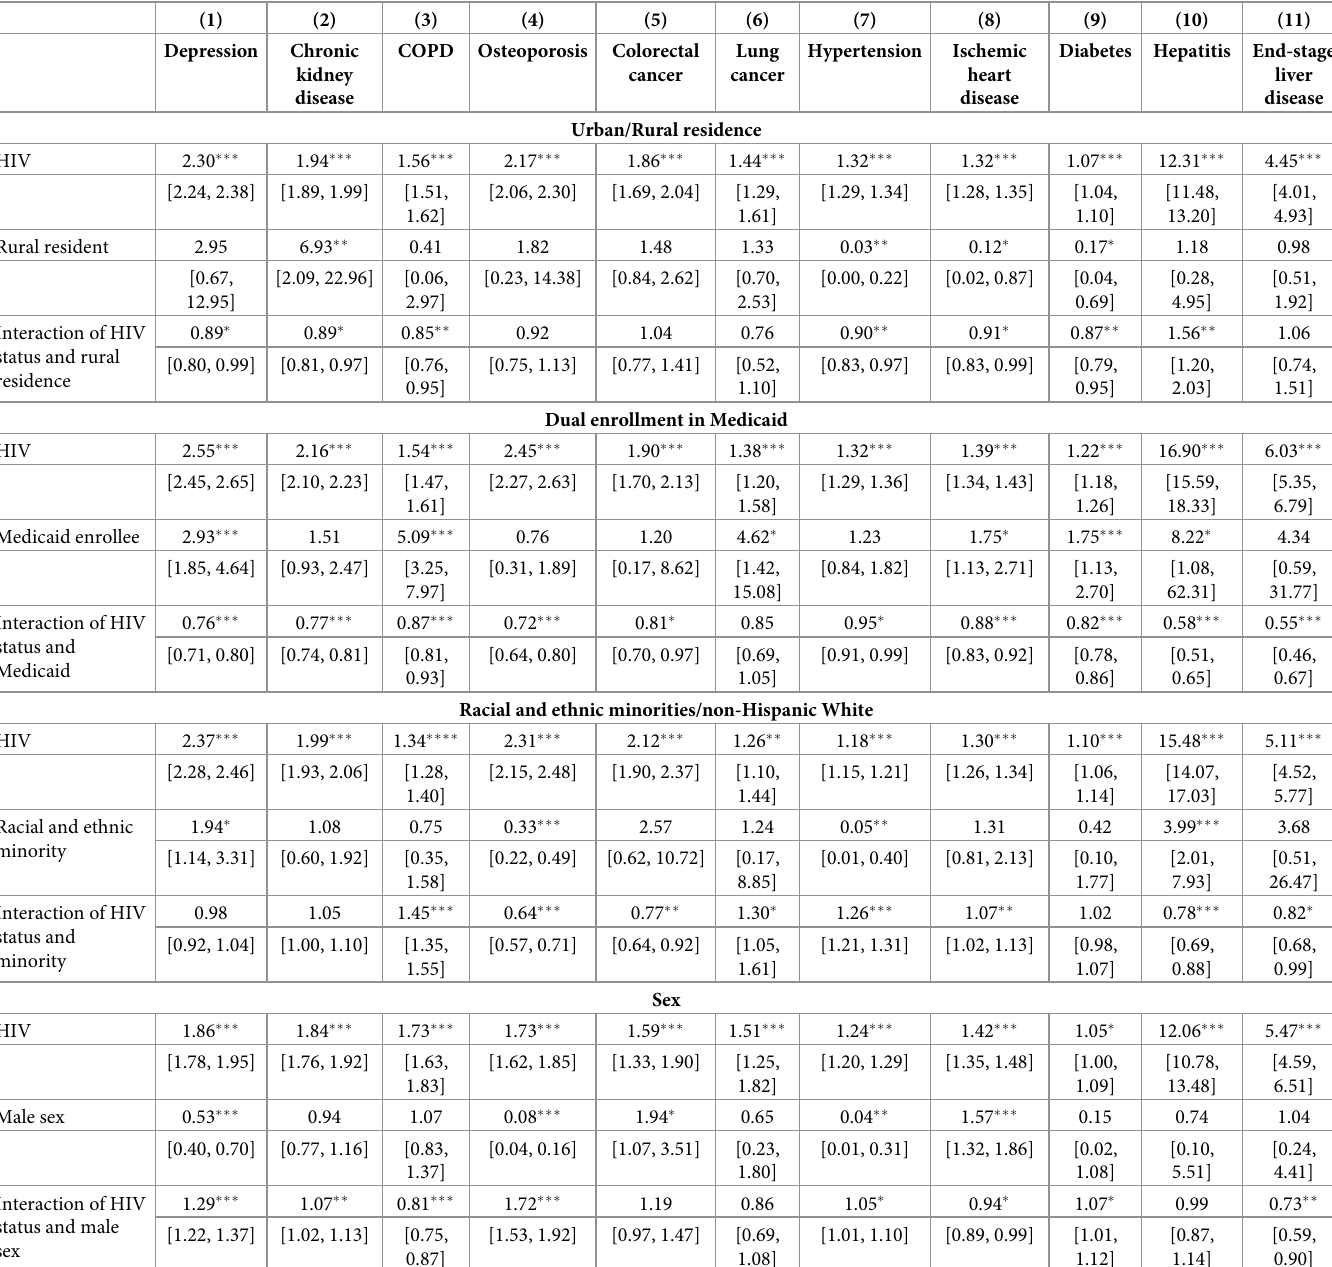
Table 4. Logit models of prevalence of health outcomes in 2016 for sub-groups of interest, odds ratios reported (Medicare beneficiaries aged 65 and older in